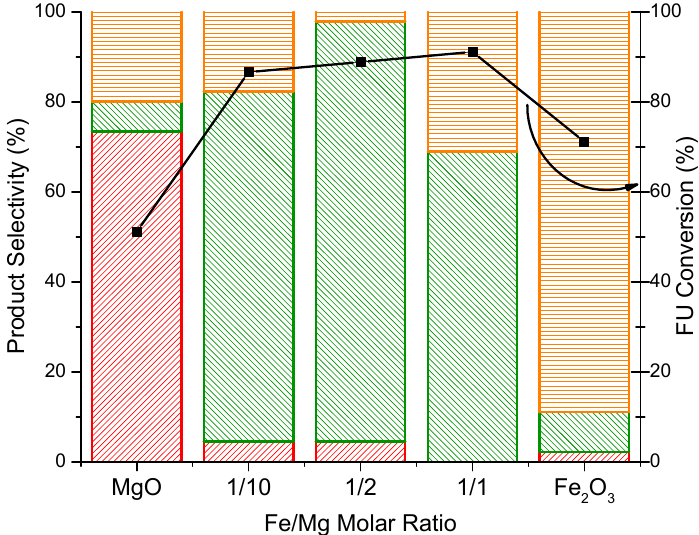
Figure 3. Profiles of coprecipitated Fe/Mg/O mixed oxide catalysts with different Fe content levels. Feed composition: 5% FU, 50% CH 3 OH, 45% N 2 , 1 atm, overall gas contact time 1.1 s, reaction time 1 h, 380 °C. Legend: FAL MFU Carbon loss FU conversion.